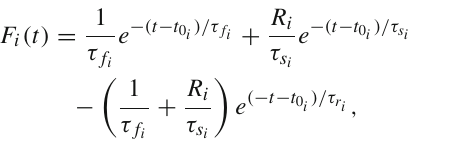
( d ) shows the averaged 60ns bin signals from the summed waveform. The offline selection of the two-pulse events is performed using the smoothed